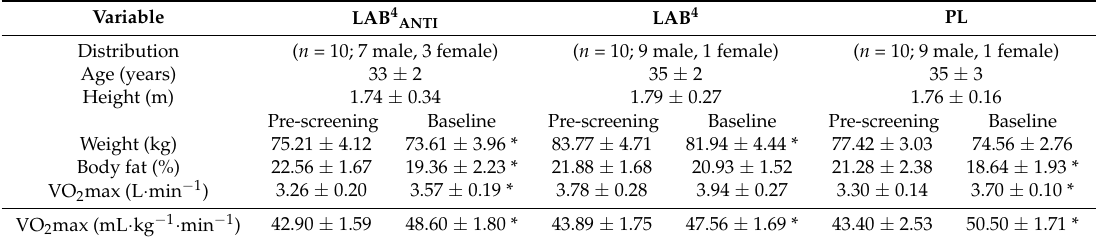
Table 1. Pre-screening (Month 0) and baseline (Month 6) characteristics for intervention